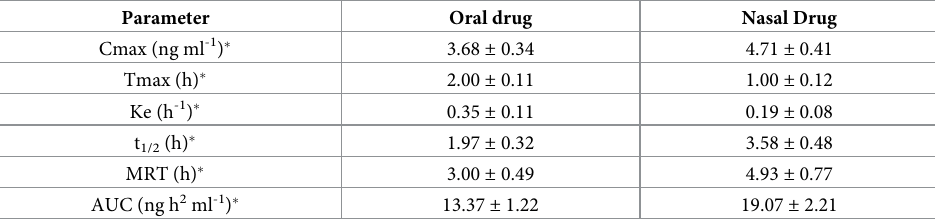
Table 1. Pharmacokinetic parameters of bromelain after oral (40 mg/kg) and nasal (10 mg/kg) administration of bromelain